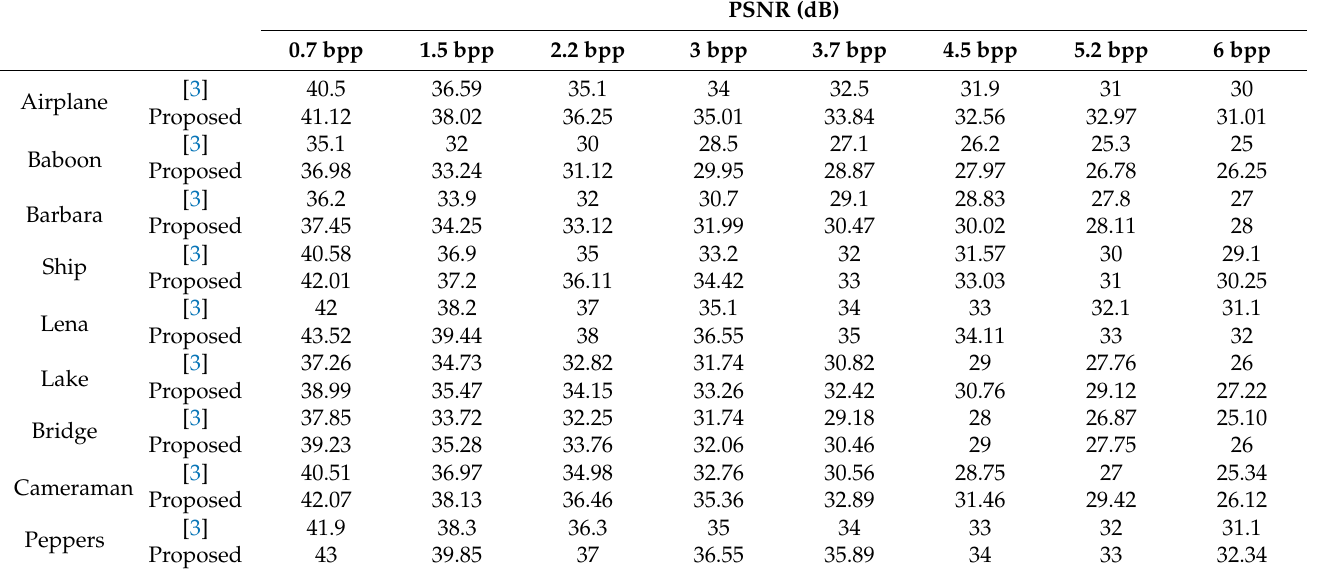
Table 5. A comparison of the PSNR (dB) value multiple-layer embedding in terms of visual quality test